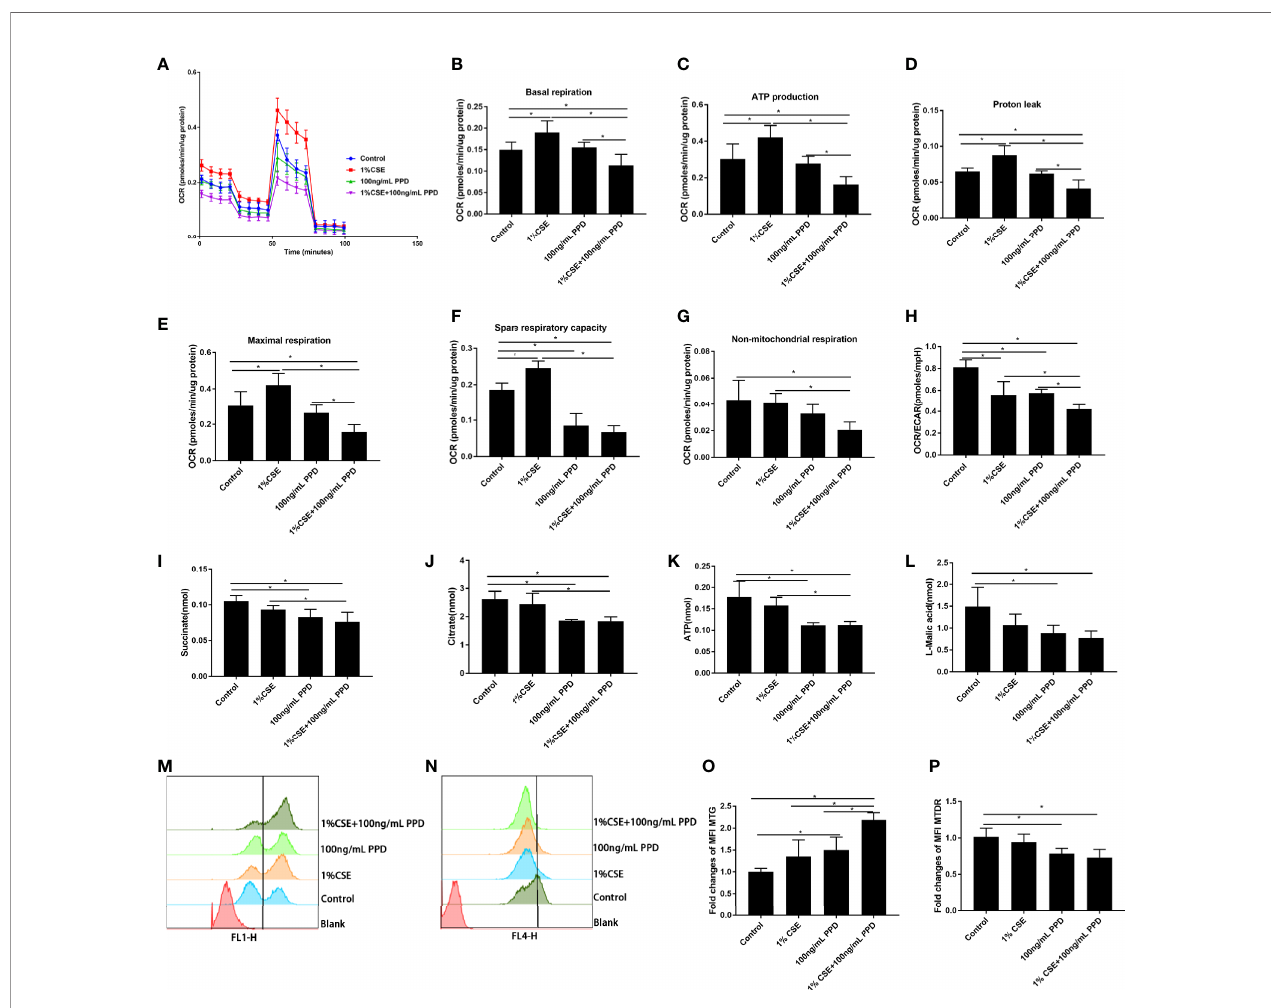
FIGURE 5 | Decreased oxidative phosphorylation in NK-92 cells upon CSE and PPD exposure. NK-92 cells were stimulated with 1% CSE and/or 100 ng/ml PPD accordingly for another 24 h The speci fi c grouping is as follows: control (control group), 1% CSE (CSE group), 100 ng/ml PPD (PPD group), 1% CSE+100 ng/ml PPD (CSE- and PPD-coexposed group). NK-92 cells were then plated onto Seahorse Biosciences plates. (A) Representative mitochondrial stress tests were conducted with sequential addition of oligomycin (1 m M), FCCP (0.125 m M), rotenone/antimycin A (1 m M). (B – H) Indices of mitochondrial respiratory function (basal respiration, ATP production, proton leak, maximal respiration, spare respiration capacity, and nonmitochondrial respiration and OCR/ECAR ratio) of CSE- and PPD-coexposed NK-92 cells. (I – K) Changes in major metabolic intermediate (succinate, citrate, ATP, L -malic acid) changes related to cellular energetic pathways (TCA cycle) were detected by LC-MS/MS. (L – O) Mitochondrial mass and mitochondrial membrane potential were detected by fl ow cytometry. n ≥ 3 independent experiments. One-way analysis of variance (ANOVA) with Bonferroni or Dunnett ’ s T3 posttest analysis was performed for comparisons between multiple groups. * p <